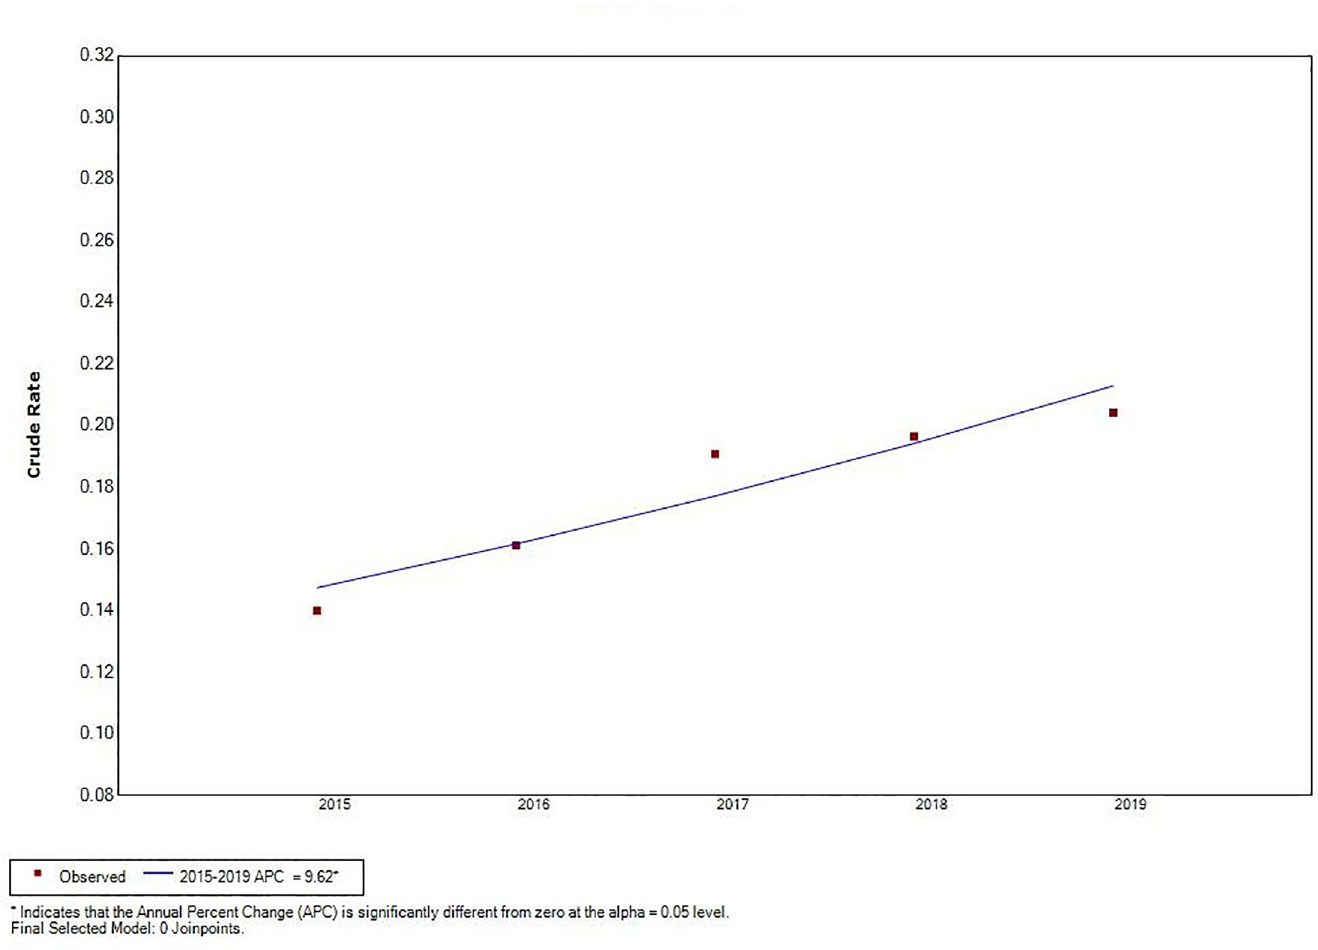
Fig 4. The joinpoint regression analysis for determining changes in the trend of mountain-type zoonotic visceral leishmaniasis incidence in main endemic areas (6 provinces of Gansu, Shaanxi, Sichuan, Shanxi, Henan and Hebei) from 2015 to 2019.